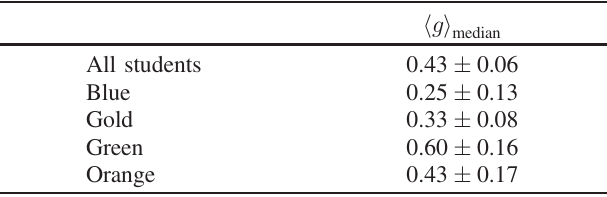
TABLE X. Median normalized FCI gains for matched students.